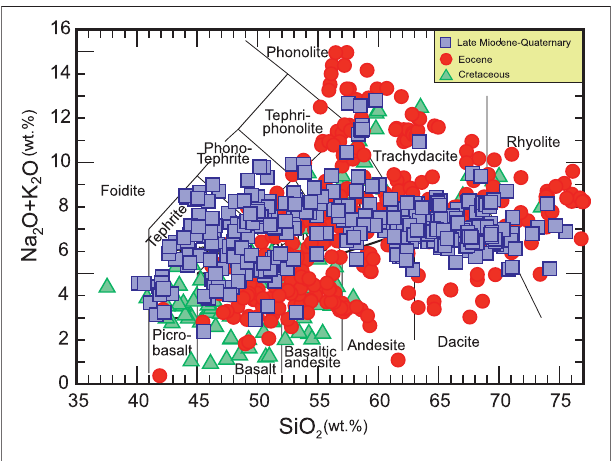
FIGURE 5 | Distribution of the composition of whole rocks, from Cretaceous to Quaternary, for all igneous rocks situated in the southern and western Caspian Sea. For references, see the text and Supplementary S2 .